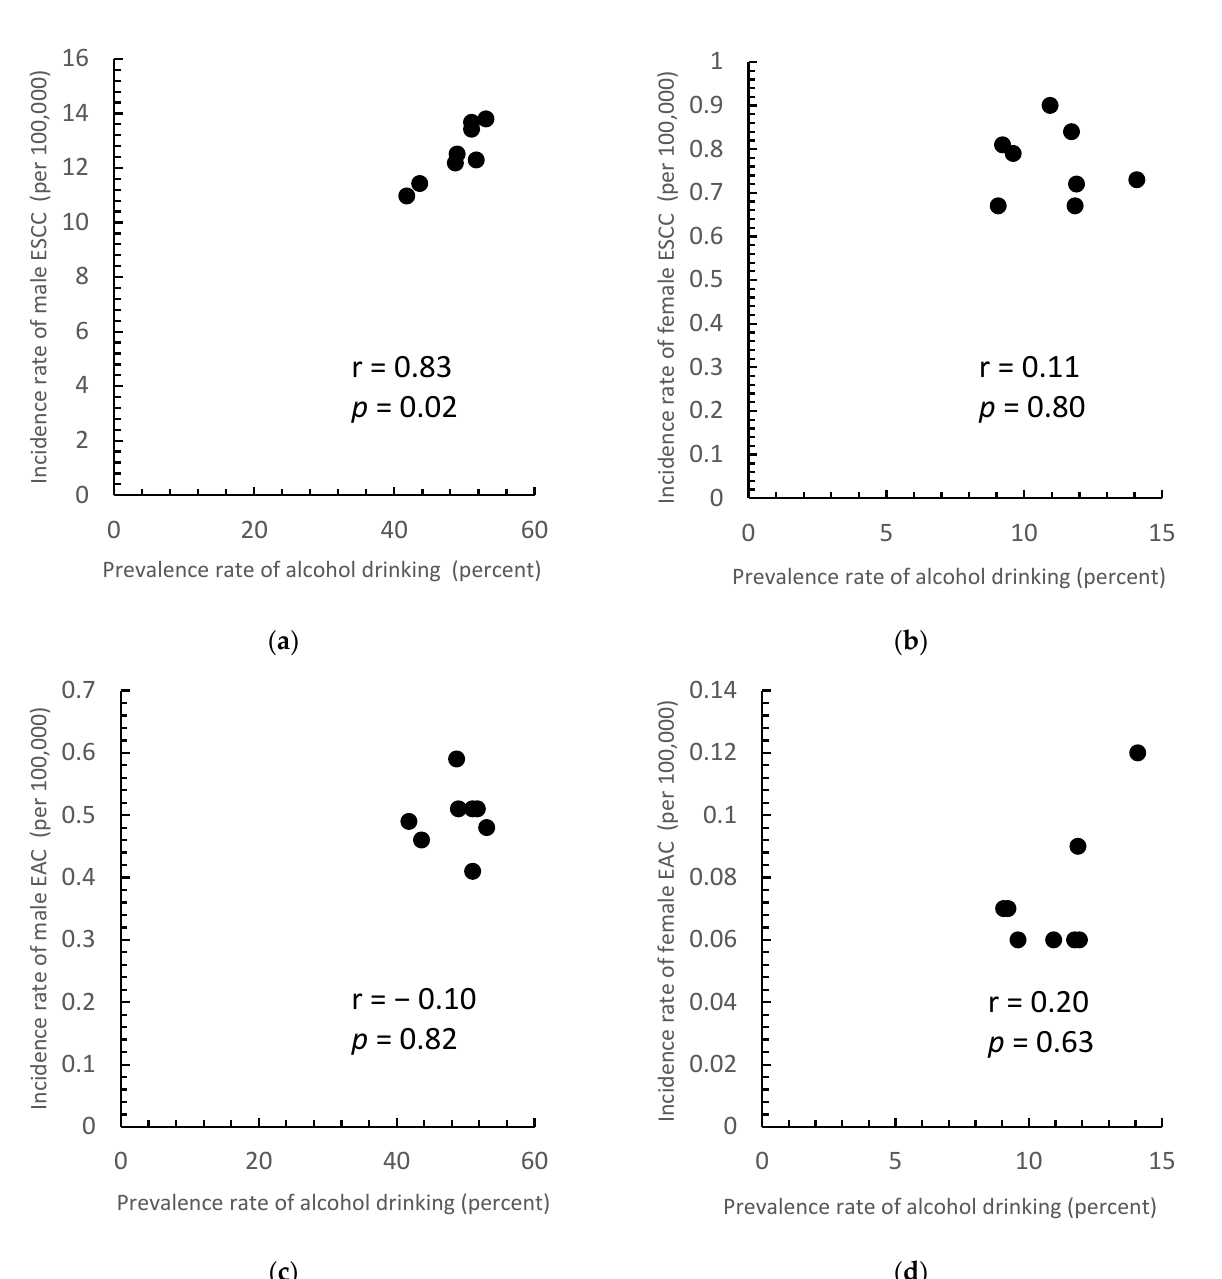
Figure 6. Correlation between the prevalence of alcohol consumption in 1971–1982 and the incidence of esophageal squamous cell carcinoma (ESCC) and adenocarcinoma (EAC) by sex for the period 2006–2017. ( a ) ESCC in men; ( b ) ESCC in women; ( c ) EAC in men; ( d ) EAC in women. Supplementary Figures S1 and S2 show the prevalence of smoking and alcohol con- sumption during 1971–1982 together with the incidence of ESCC and EAC in 2006–2017. The prevalence of smoking in men was high from 1971 to 1990 (58.48% to 59.41%) and then decreased significantly from 1992 to 2016 (57.86% to 28.60%) (Figure S1a,c). The prevalence of smoking in women remained stable from 1971 to 1982 (4.25% to 4.22%), decreased from 1982 to 1986 (4.22% to 2.32%), increased from 1986 to 2002 (2.32% to